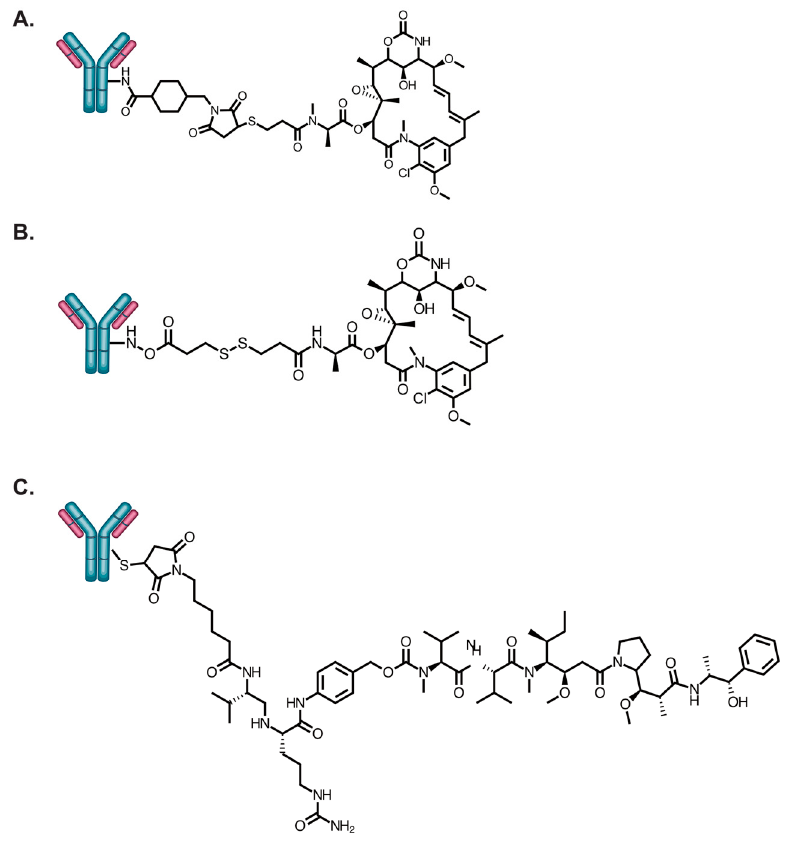
Figure 2. Structures of trastuzumab-based ADCs evaluated for cellular payload accumulation. ( A ) T-DM1, ( B ) T-SPP-DM1, and ( C ) T-vc-MMAE.